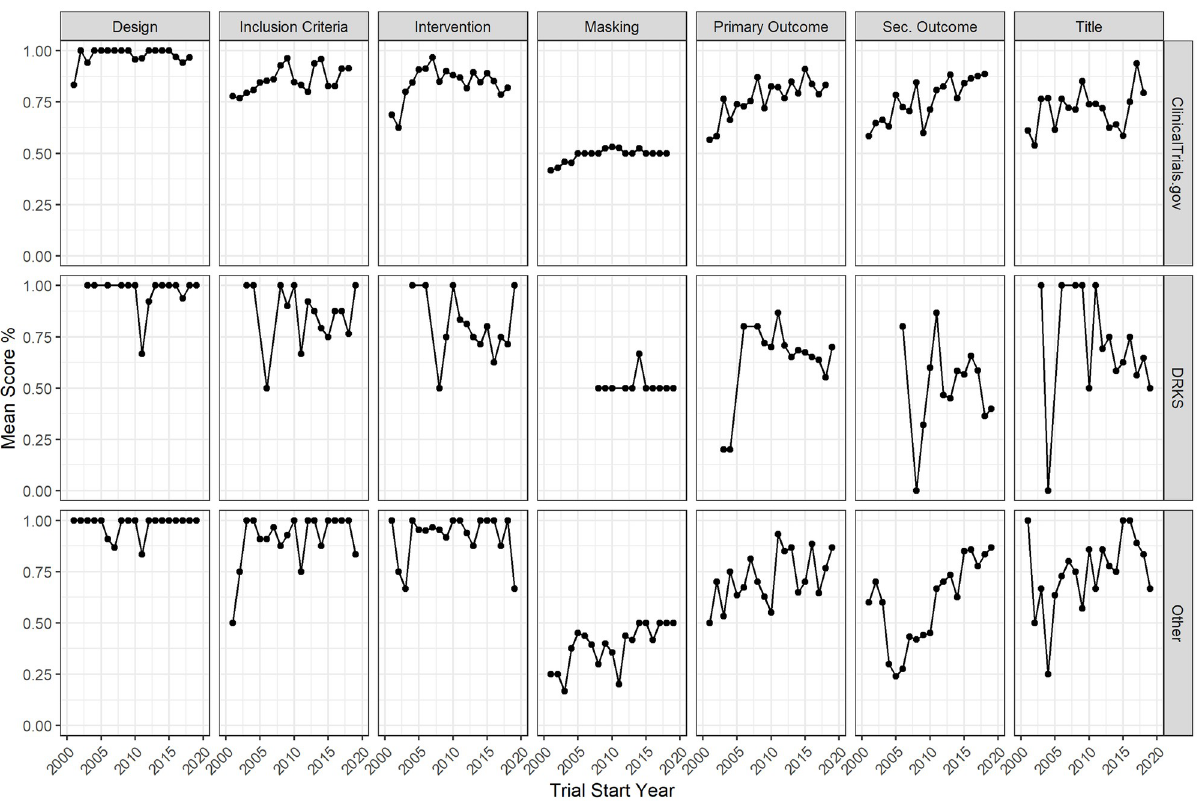
Fig 2. Trends in registration quality over time separately for the different registries.